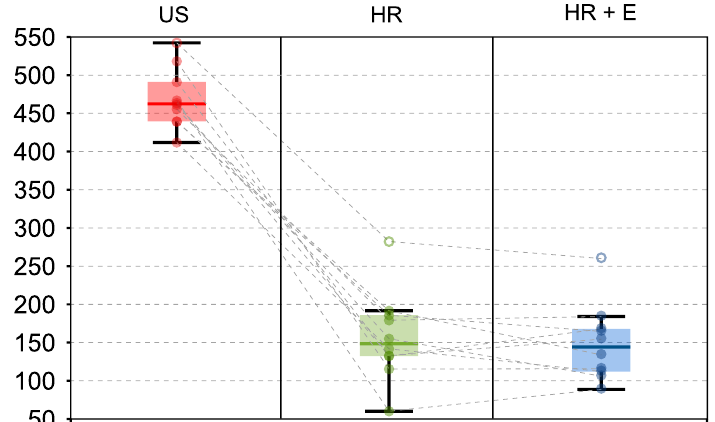
Figure 3. Average of the maximum COP displacement computed for each user along each of the three conditions: Unsupported (US), Hand rail support (HR), and Hand rail support with hand exoskeleton (HR + E). There is a significant reduction of this displacement when the external support is used, but there is not a significant difference between using the exoskeleton or